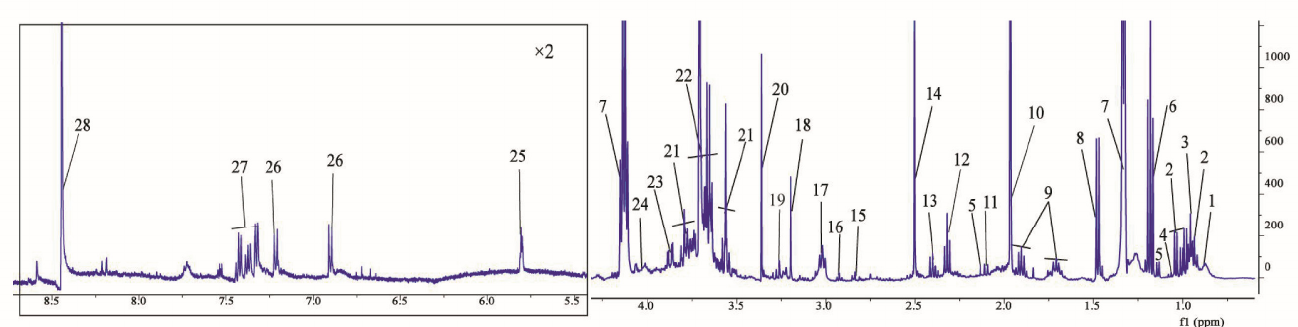
Figure 3. Representative 1 H NMR metabolic spectrum of DFC after 48 h in vitro fermentation. Note: 1, valeric acid; 2, isoleucine; 3, leucine; 4, valine; 5, propionic acid; 6, ethanol; 7, lactic acid; 8, alanine; 9, lysine; 10, acetic acid; 11, butyric acid; 12, glutamic acid; 13, succinic acid; 14, citric acid; 15, dimethylamine; 16, trimethylamine; 17, isobutyric acid; 18, choline; 19, betaine; 20, methanol; 21, β -glucose; 22, α -glucose; 23, aspartic acid; 24, histidine; 25, uracil; 26, tyrosine; 27, phenylalanine; 28, formic